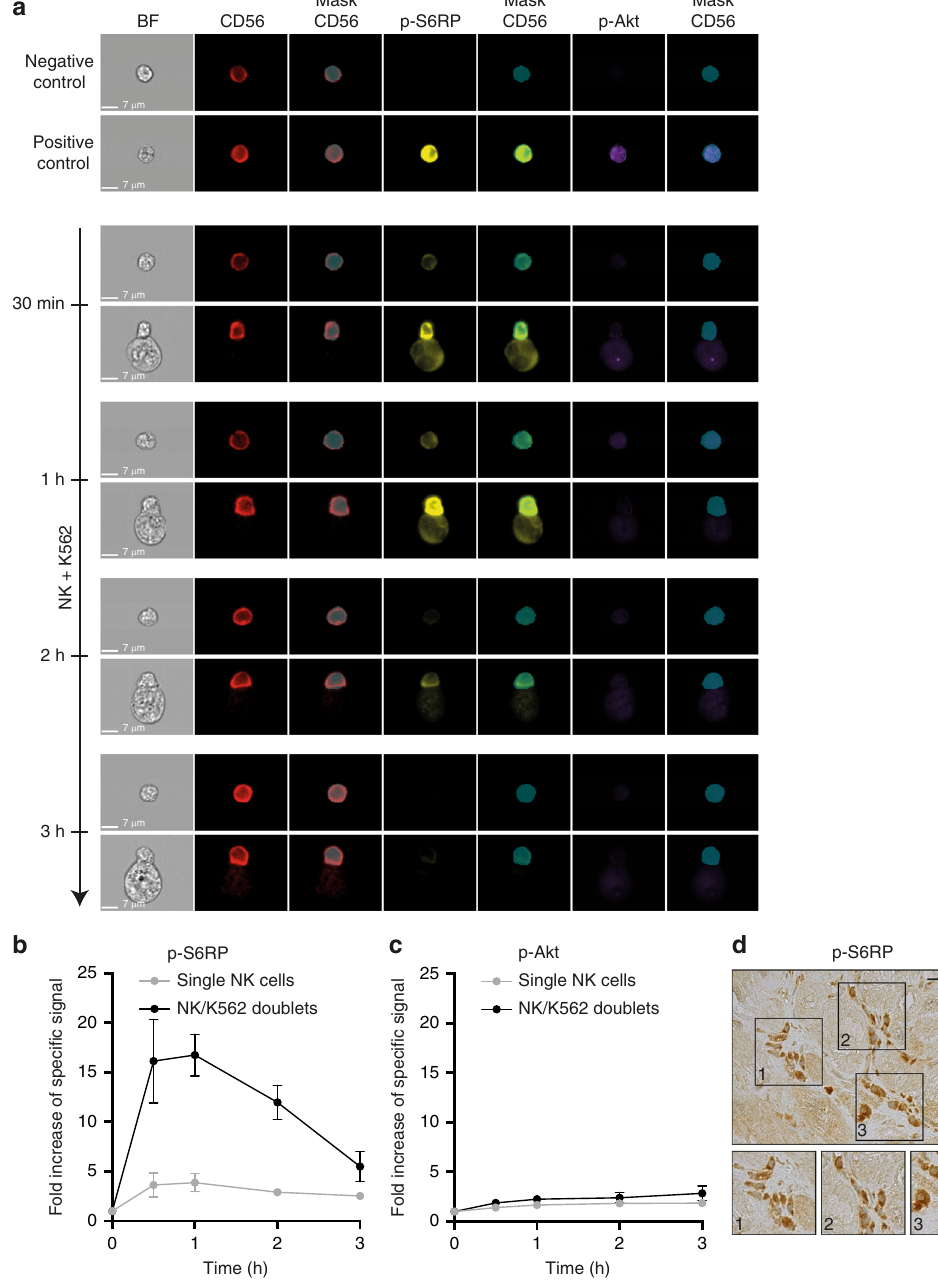
Fig. 7 Missing self-induced NK cell activation is mTORC1-dependent. a – c Puri fi ed NK cells from a healthy donor were co-cultured with HLA-de fi cient K562 cells. An imaging fl ow cytometer was used at indicated time points to detect the phosphorylated form of S6 ribosomal protein (S6RP, downstream mTORC1) and of protein kinase B (Akt, downstream mTORC2), in isolated NK cells and NK cells that form doublets with K562 target cells. a Representative images of NK cells cultured alone (negative control), in the presence of IL-15 (positive control), and from co-cultures with K562 cells are shown. b The intensity of the signal corresponding to the phosphorylated form of S6RP was measured at various time points in NK cells (CD56 mask), isolated (grey curve) or in doublet with K562 cells (black curve). Data were normalised over baseline; mean ±standard deviation. c The intensity of the signal corresponding to the phosphorylated form of Akt was measured at various time points in NK cells (CD56 mask), isolated (grey curve) or in doublet with K562 cells (black curve). Data were normalised over baseline; mean± standard deviation. d Graft biopsies of heart transplant patients diagnosed with missing self-induced NK- mediated rejection were stained for the phosphorylated form of S6 ribosomal protein (p-S6RP), which is located downstream mTORC1. A representative image is shown. Scale bars: 100 µ m. Source data are provided as a Source Data fi